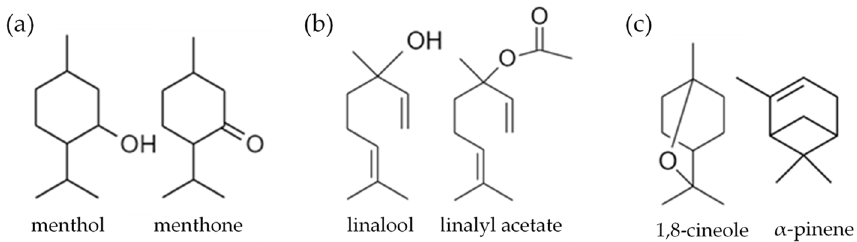
Figure 2. Chemical structures of main constituents of ( a ) peppermint oil; ( b ) lavender oil and ( c ) eucalyptus oil.